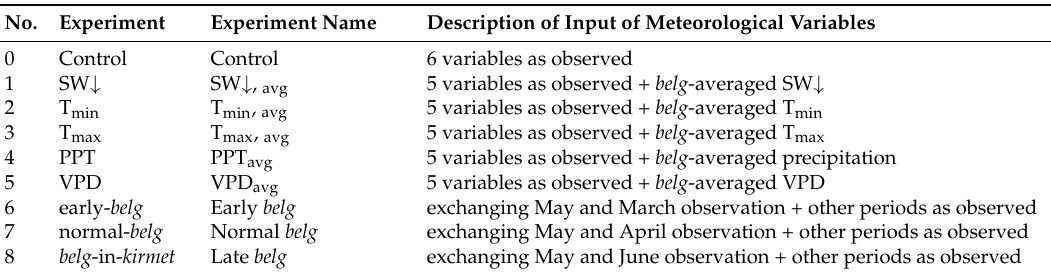
Table 3. GECROS model sensitivity experiment design. Key: PPT—precipitation; VPD—vapor pressure deficit.